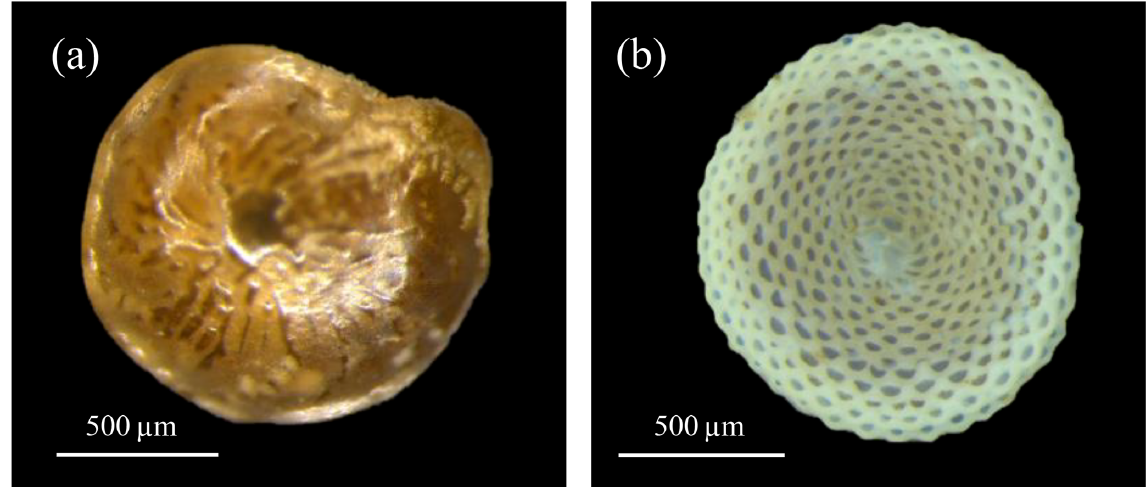
Figure 1. The holobionts examined in this study. (a) Amphistegina lobifera and (b) Sorites orbiculus . Note the greenish-brown colour of the symbiont algae.